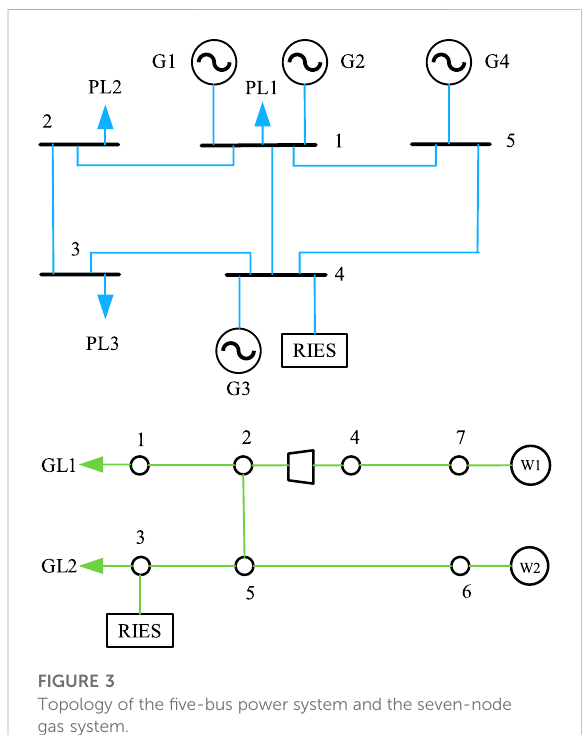
Table 2. Carbon emission intensities of different types of units in the electricity network are shown in Table 3.